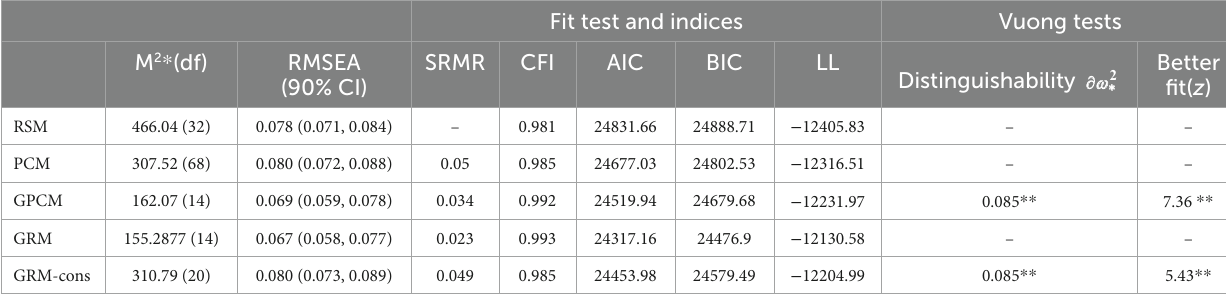
TABLE 3 Fit of polytomous IRT models for GAD-7